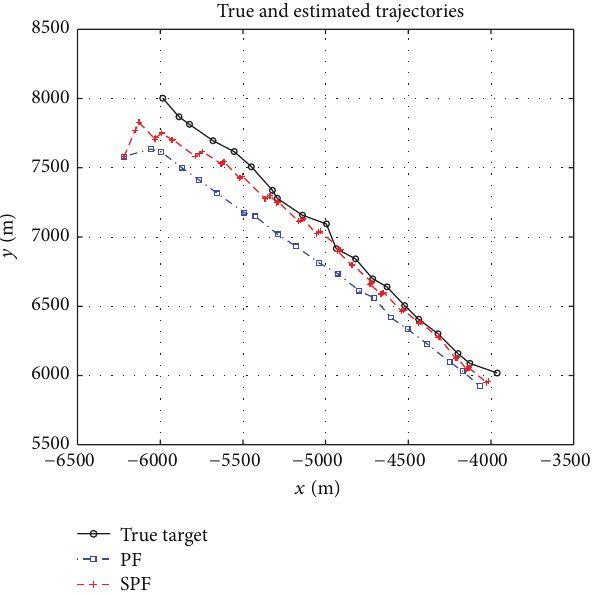
Figure 11: RMSE for a target with constant velocity, as well as Gaussian distributed acceleration and heading direction (20MC trials).